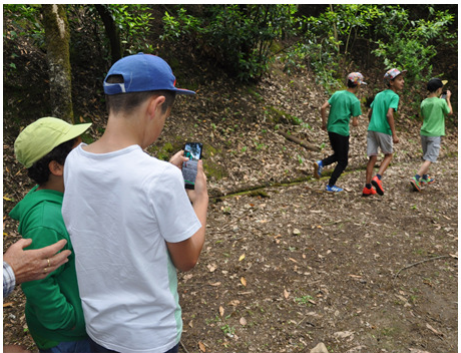
Figure 4. Experience with 76 children in 2017 children’s day.